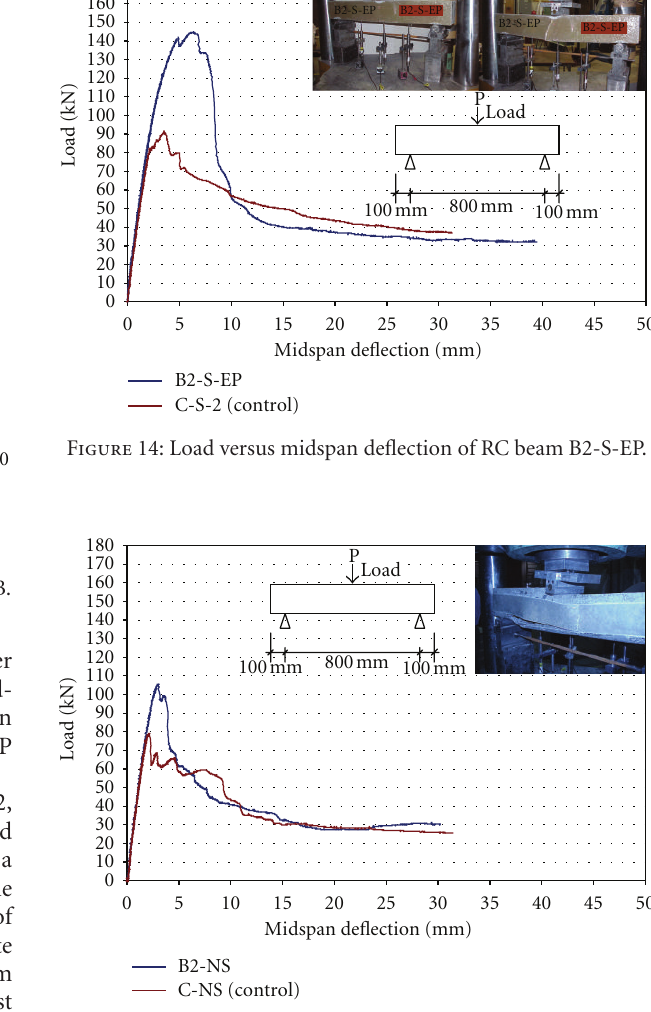
Figure 15: Load versus midspan deflection of RC beam